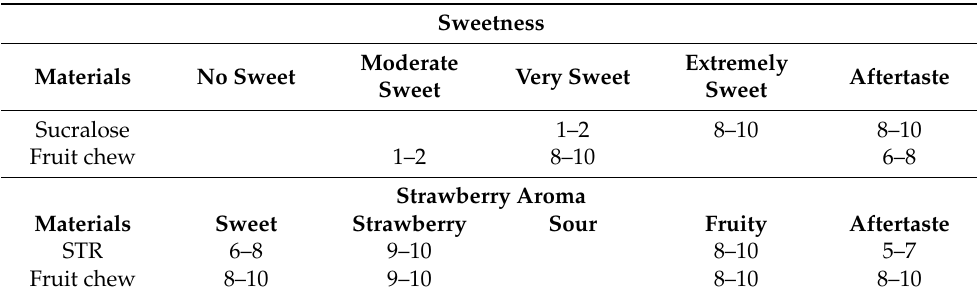
Table 2. Number of subjects reporting sweetness and strawberry aroma of bulk substances and 3D printed fruit